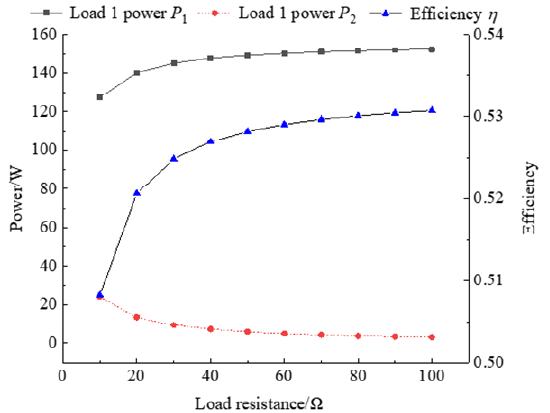
Figure 11. System parameter curve when load 2 changes in coaxial same-side coupling.